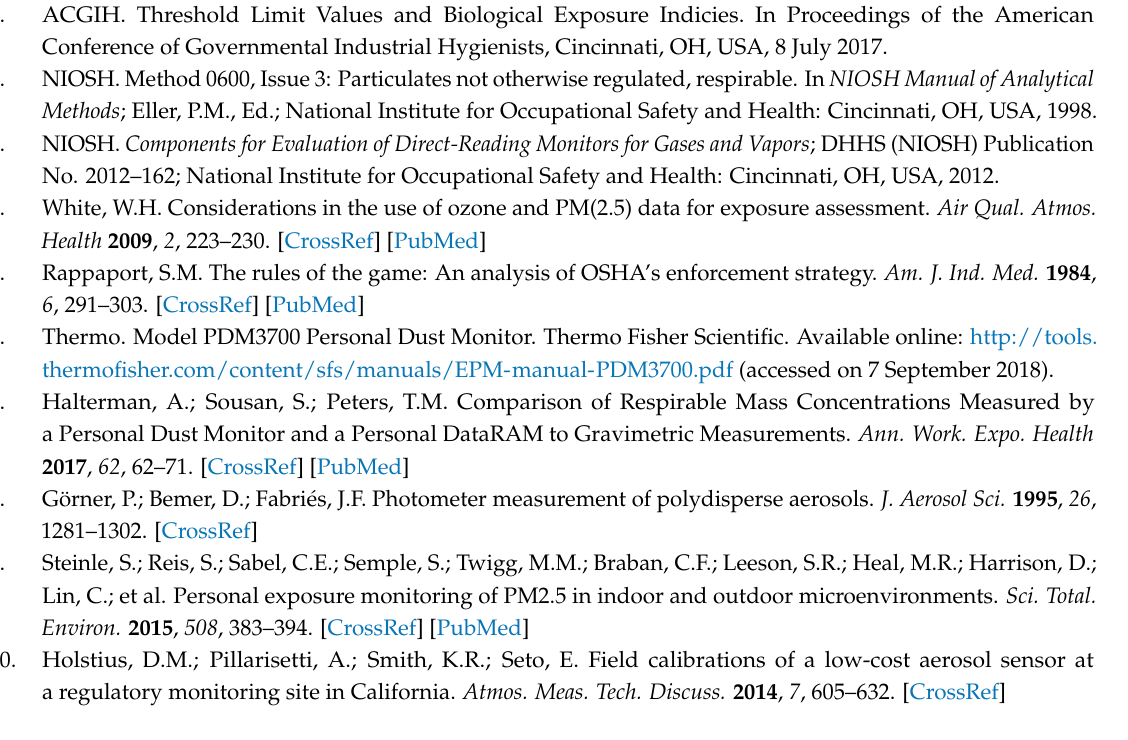
Figure S1, Intercept (mv) compared to the value measured at zero concentration (mV) for 100 sensors. The x -axis error bars represent one standard